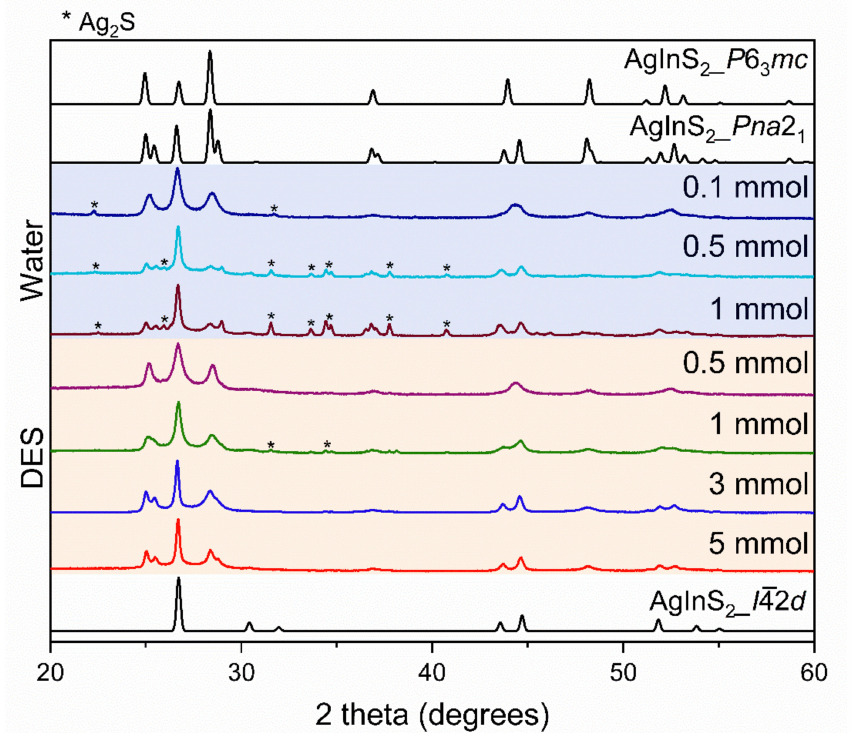
Figure 4. PXRD patterns of the 2-step synthesis of water (blue shaded region) and DES-synthesized AgInS 2 (orange shaded region), with varying concentrations of metal precursors. Diffraction peaks for the Ag 2 S impurity are denoted with an asterisk (*). The theoretical PXRD patterns include ICSD 51617, representing the I 42 d ; ICSD 76276, representing the P 6 3 mc ; and ICSD 605408, representing the Pna 2 1